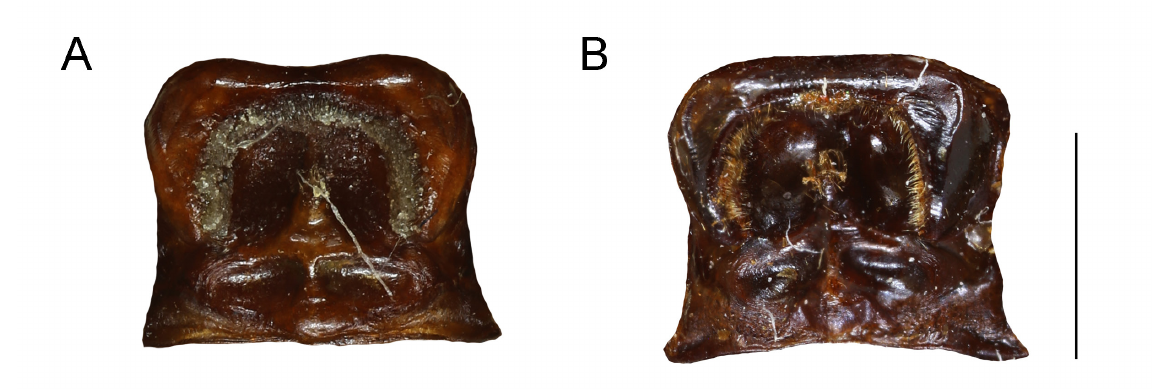
Fig. 15. Metanotal gland. A . Nisitrus hughtani Robillard & Tan sp. nov. B . N. brunnerianus Saussure, 1878. Scale bar = 2